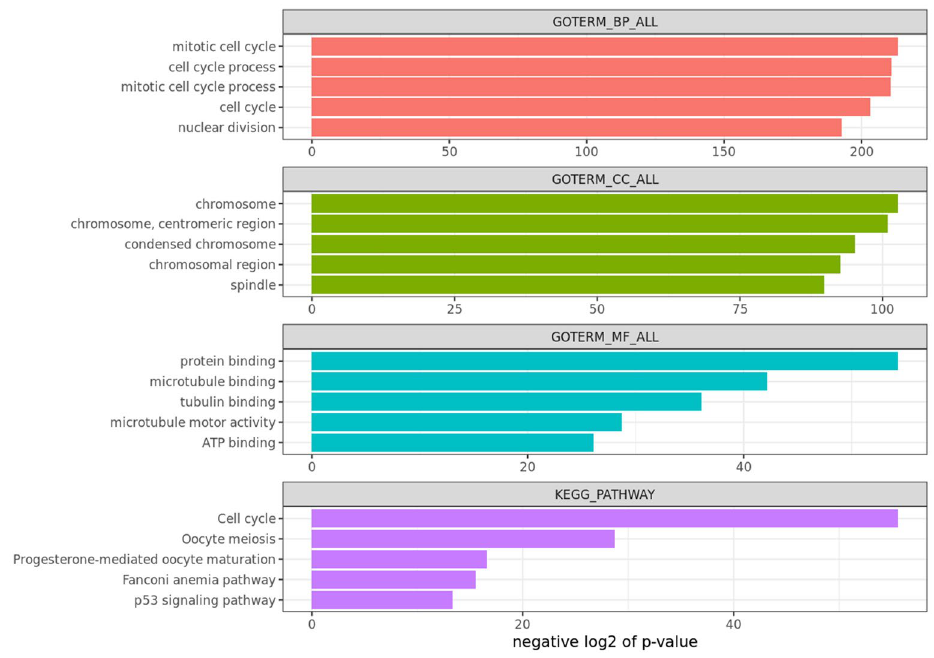
Figure 4. Functional enrichment analysis of the top 300 correlated genes with the predicted risk in TCGA BRCA cohort.